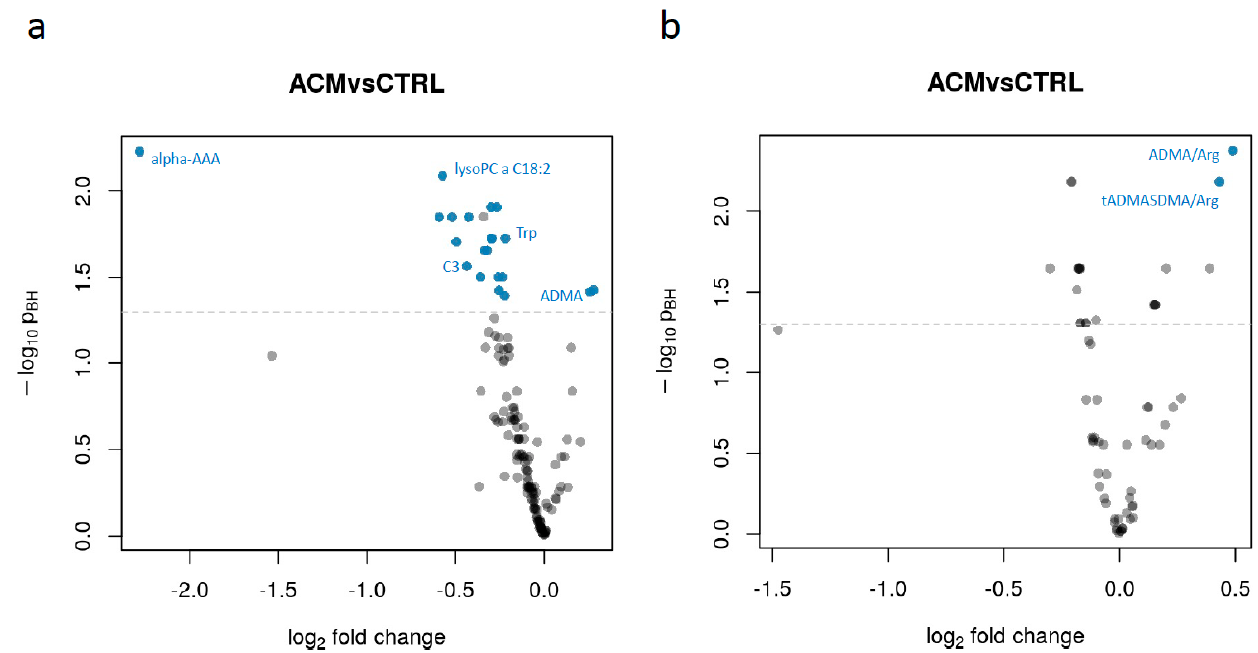
Figure 1. ( a ) Principal component analysis of plasma metabolites shows that ACM (red squares) clusters from CTRL (purple dots) samples ( b ) Enrichment analysis highlights the main pathways affected in ACM samples.